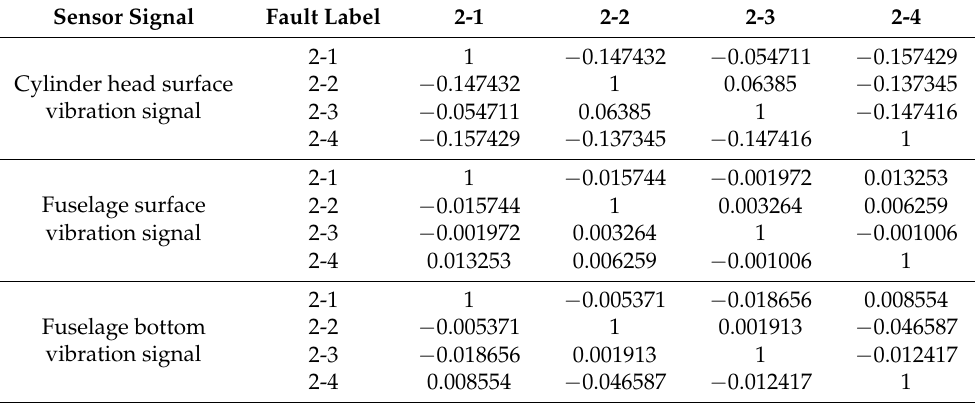
Table 2. Cylinder fault data